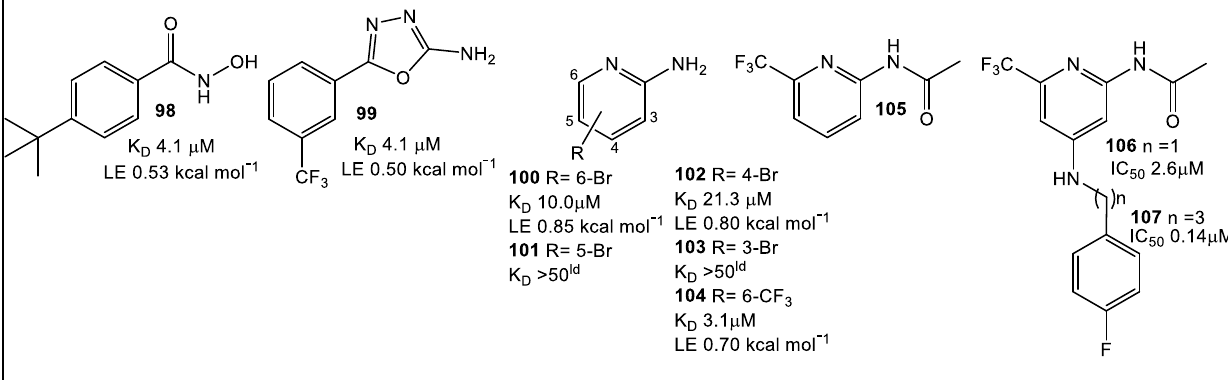
Figure 17. Optimal starting point identification using thermodynamic profiling of fragment sized PqsR ligands. A re-evaluation of the 98 , 99 , and 100 fragment scaffolds showed that 100 has re- markably improved enthalpic efficiency (EE) and ligand efficiency (LE) values. Hit 100 led to 104 optimization resulting in 106 , which enabled further optimization through flexible fragment growing. The N -propyl amine linker in 107 shows an increase in potency (20-fold). Crystallography of 107 in complex with PqsR91-319 reveals the extended linker pointed further into the pocket containing the alkyl chain of the natural